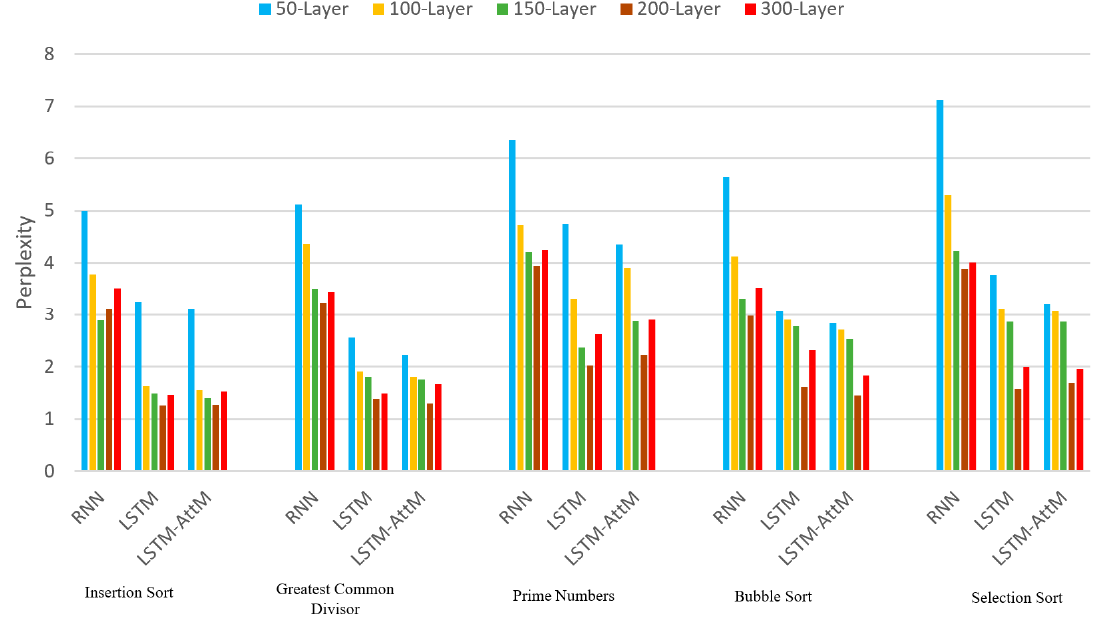
Figure 5. Perplexity values at last epoch of proposed and other state-of-the-art models during the training period for various problem